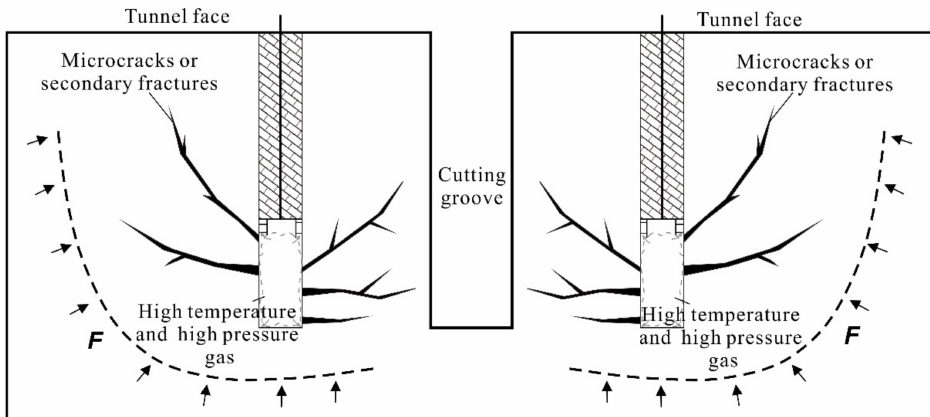
Figure 2. The operating principle of expansion pipe (vertical